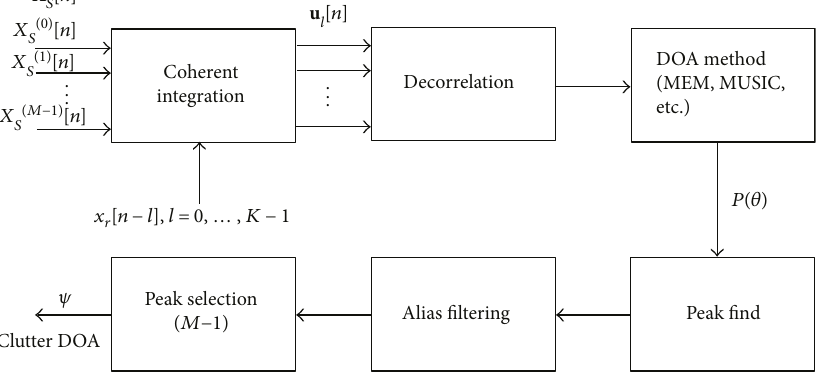
Figure 6: Signal processing chain for clutter DOA estimation.